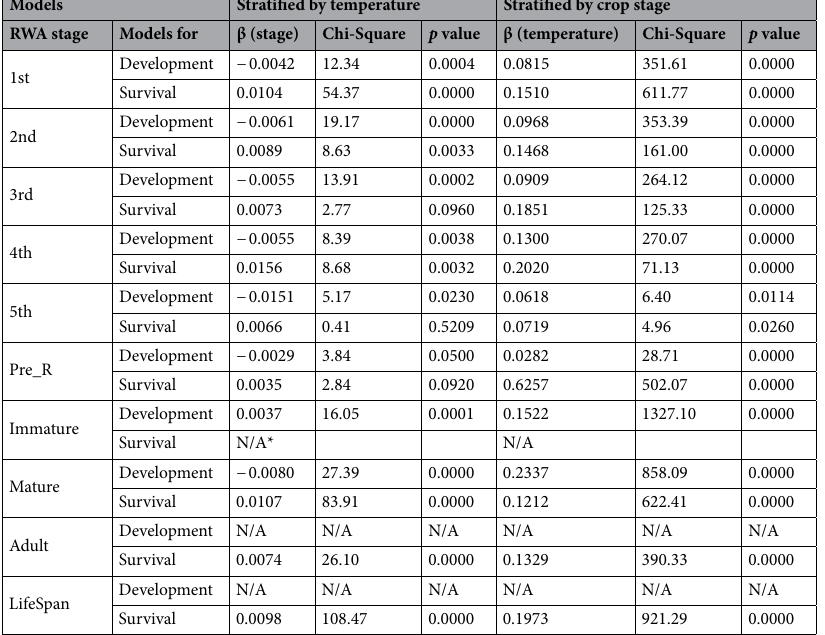
Table 3. Results of fitting stratified proportional hazards models for RWA development and survival. N/A refers to stages where there is only one event (development or survival) that makes sense biologically, or both development and survival refer to the same event. For example, the completion of development of the adult stage is equivalent to the death of the